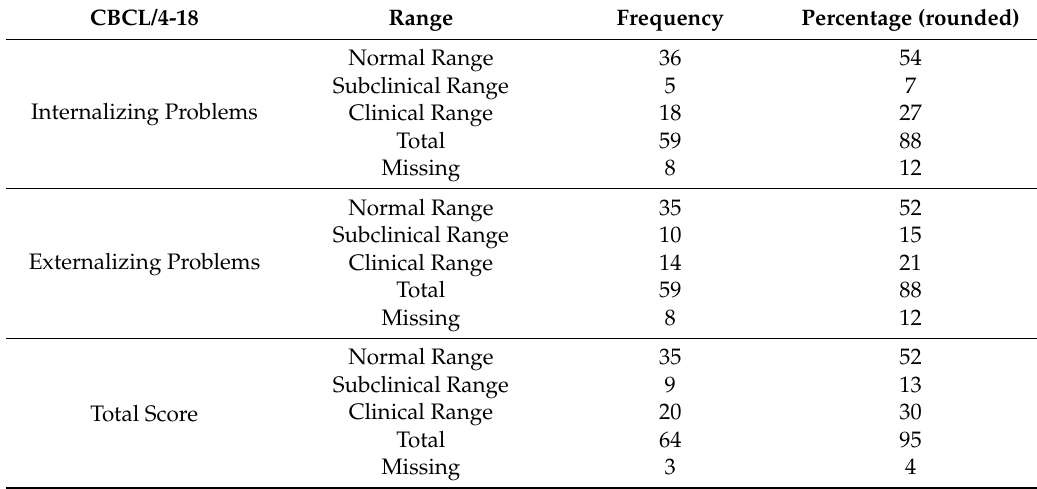
Table 2. T-values of the CBCL/4-18 in the normal, subclinical and clinical range.